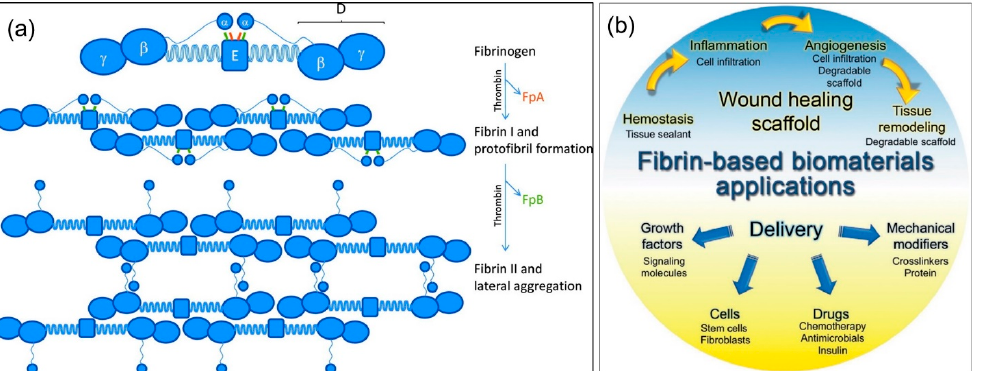
Figure 2. ( a ) Fibrinogen to fibrin formation. The α -chain termini fold back on the coiled-coil and interact with the E-region. Fibrin formation involves the cleavage of FpA (orange) by thrombin (fi-